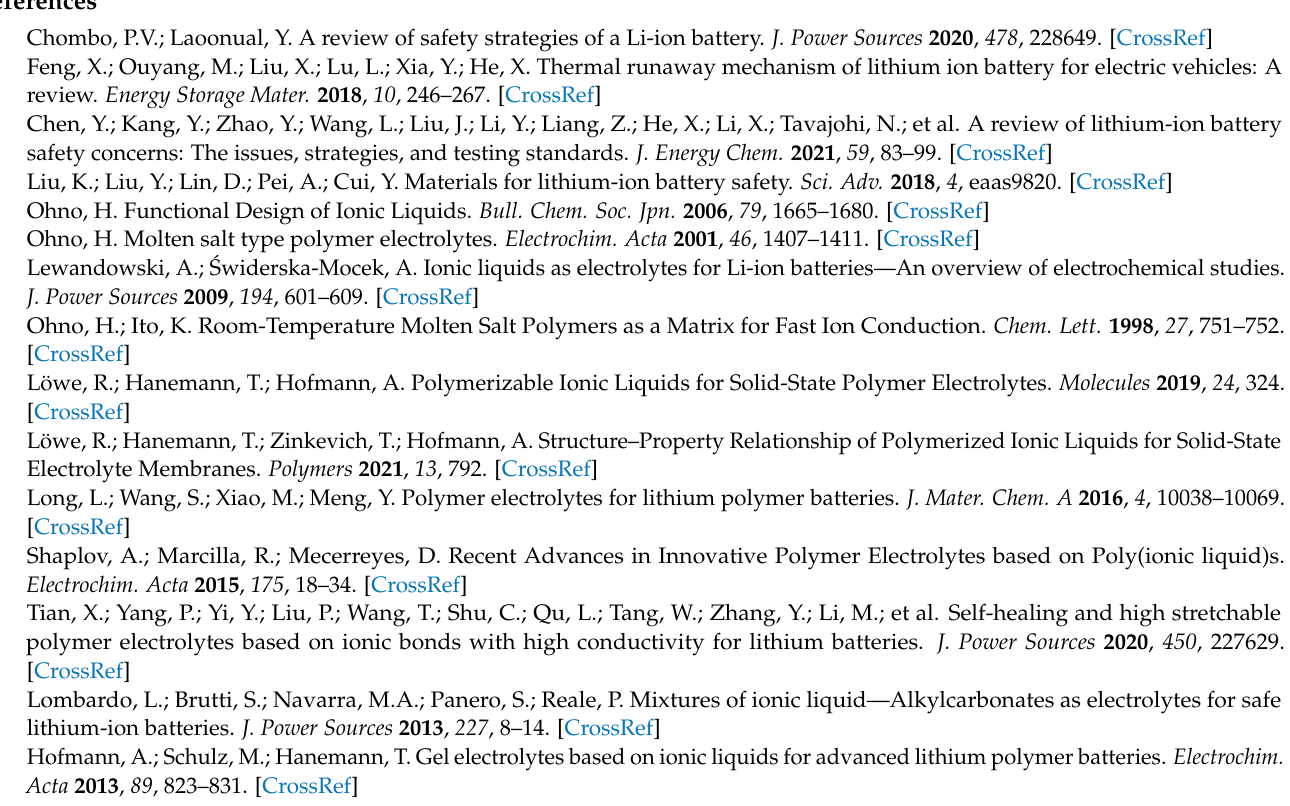
2.5 wt% cross-linker and additional 45 wt% MPPyrr-TFSI (PIL_7_1) (left) and 45 wt% EC (PIL_7_6) (right), Figure S3: Used equivalent circuit for fitting of the EIS data, Figure S4: Exemplary EIS data and fit of a single measurement (given data in the manuscript are average results of 4 single measurements) for the PIL membranes of P[C 8 N A,22 ]TFSI with 2.5 wt% cross-linker and additional 45 wt% MPPyrr-TFSI (PIL_7_1) (left) and 45 wt% EC (PIL_7_6) (right) at 25 ◦ C, Table S1: Overview over the compositions of the PIL membranes with 45 wt% MPPyrr-TFSI and TMPTA as cross-linkers, Figure S5: Cell test of the polymer electrolyte with MPPyrr-TFSI to EC ratio of 1:1 (PIL_7_4) at 70 ◦ C with the electrode combinations NMC against lithium (left; C/200) and LFT against LTO (right; C/100), Figure S6: Cell test of the polymer electrolyte with 100% EC as liquid electrolyte (PIL_7_6) at 25 ◦ C (left) and 70 ◦ C (right) and LFP against LTO electrodes at